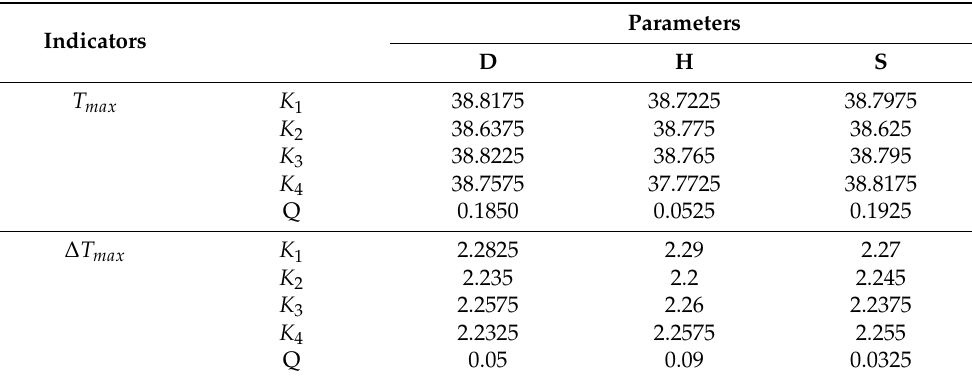
Table 6. Results of orthogonal experimental analysis.